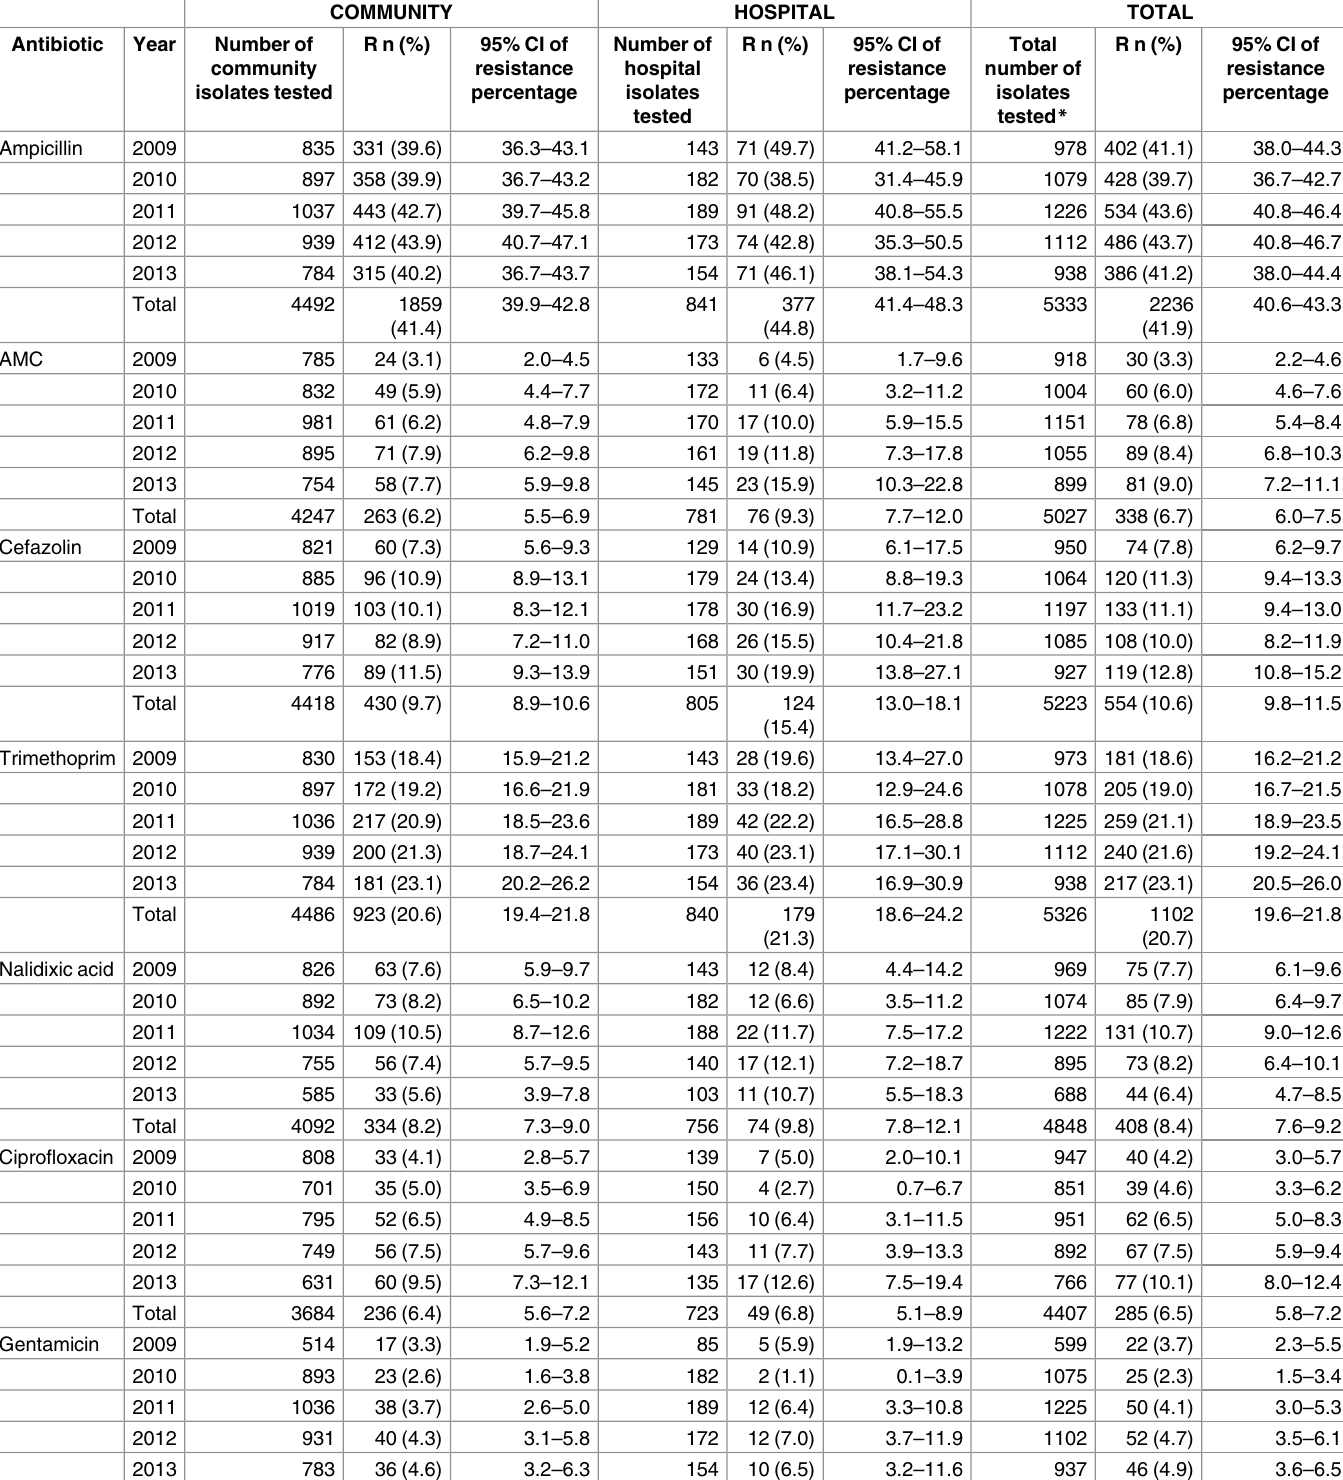
Table 1. Resistance profile of urinary E . coli isolates sent for routine susceptibility testing from 2009 to 2013 by setting.